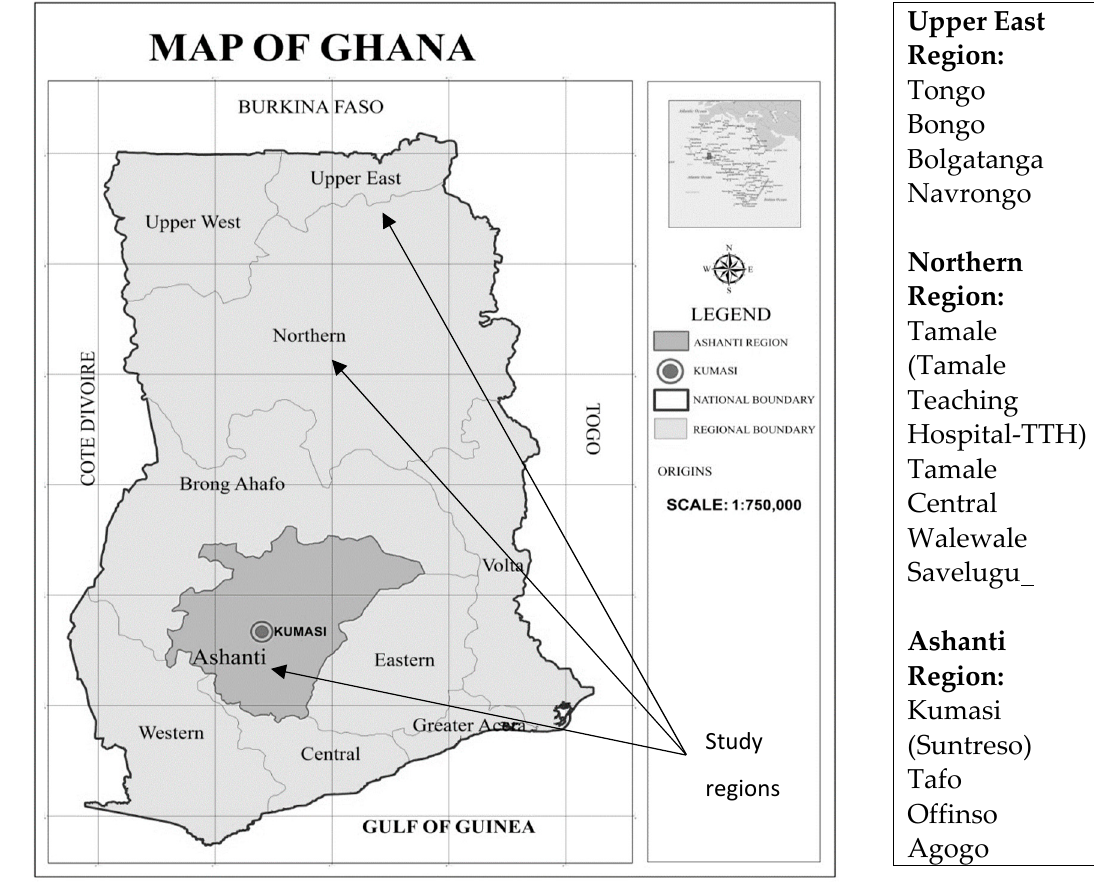
Figure 1. Map of the study